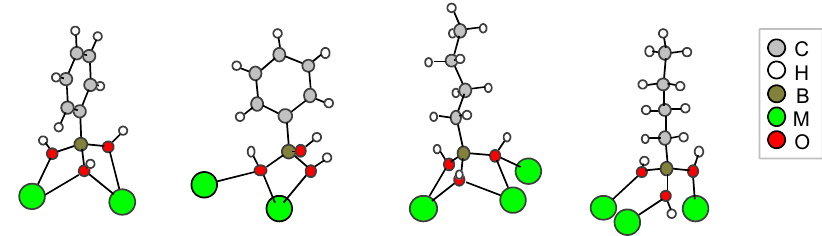
Figure 5. Coordination modes of phenyl and butylboronate ligands with respect to alkaline earth metals (M = Ca, Sr) [22–24]. For the octylboronate ligand, the same binding mode as for the butylboronate was observed [24]. Adapted with permission from [22] (copyright American Chemical Society, 2011), [23,24] (copyright Wiley-VCH Verlag 2013 and 2015) and [25] (copyright Actualité Chimique, 2014).